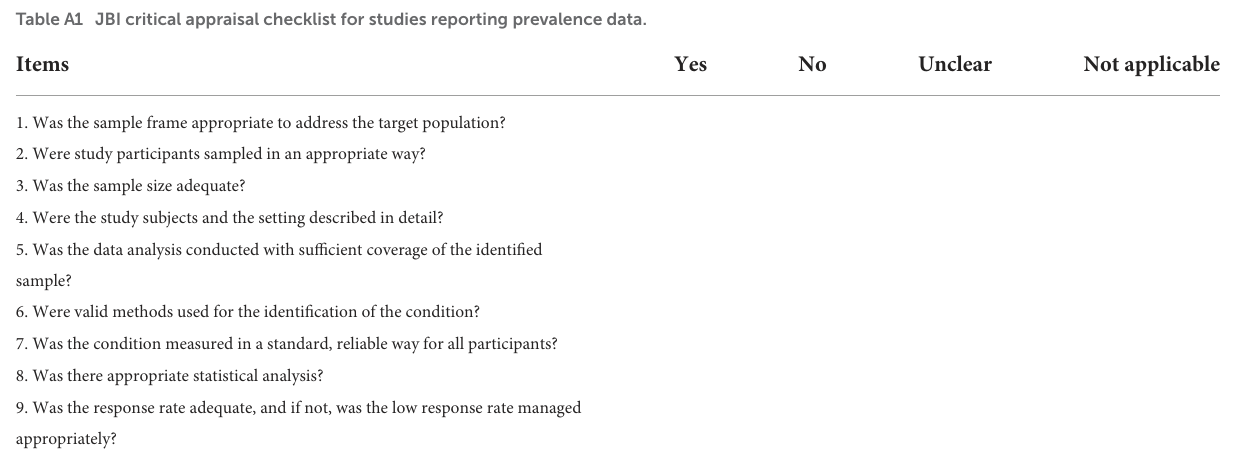
Table A1 JBI critical appraisal checklist for studies reporting prevalence